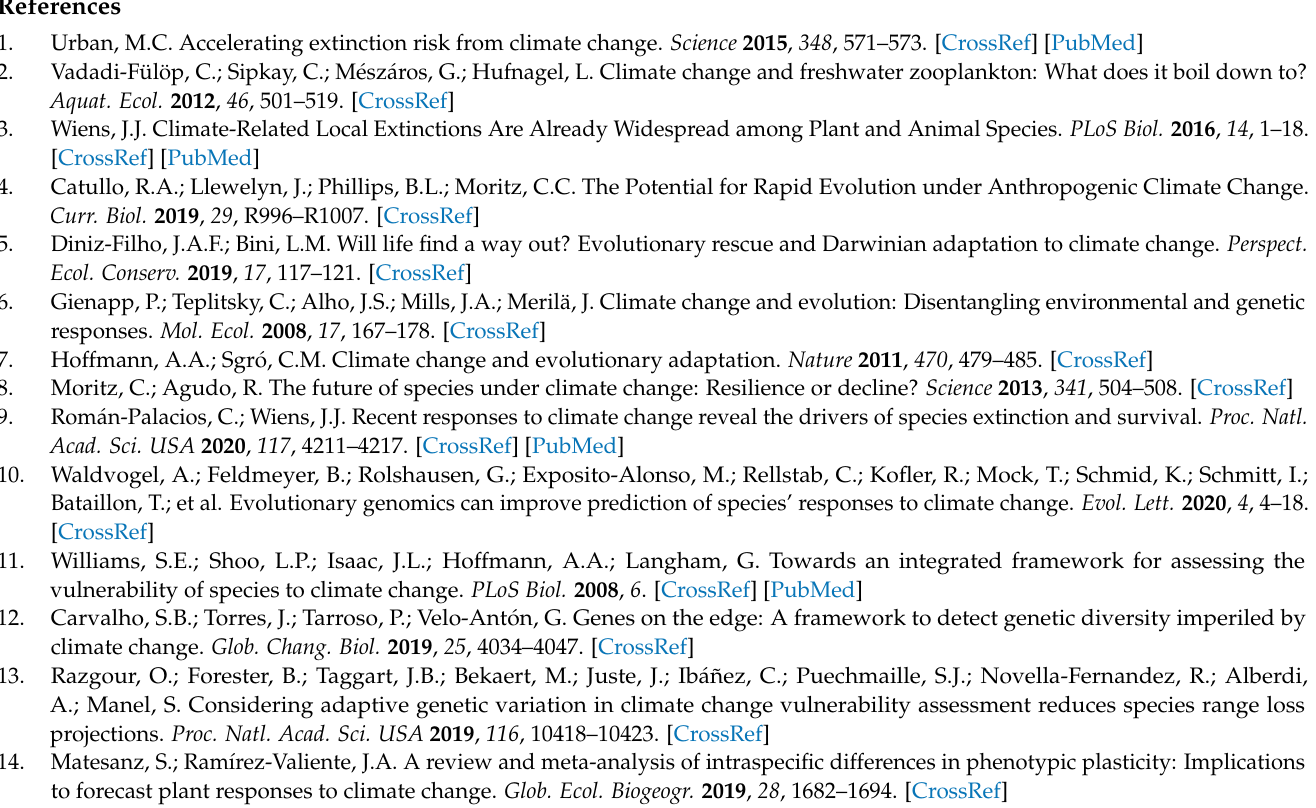
Table S3. Correlation coefficients and p values estimated from the correlation analysis. The factor’s values were relative to the model output extinction of the egg bank. Figure S2. Hierarchical doughnut chart reported from the center to the border: the two climatic conditions: present and climate change; the factors: hatching rate (H), probability that the water balance is positive (P), the mean number of resting eggs produced per female (Y), and the deterioration rate (D); the clonal lineages: W1, W2, S2, L, I2, S1, and I1; the Sobol first index; and the Sobol total index. Sobol’s indices that differ in importance among clones were reported in the manuscript and they were represented underlined and in